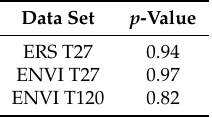
Table 4. Results of Student’s T-test for equal means (e.g., [35], p. 521). H 0 : means are equal; H 1 : means are significantly different; p -value: probability of rejecting H 0 when it is